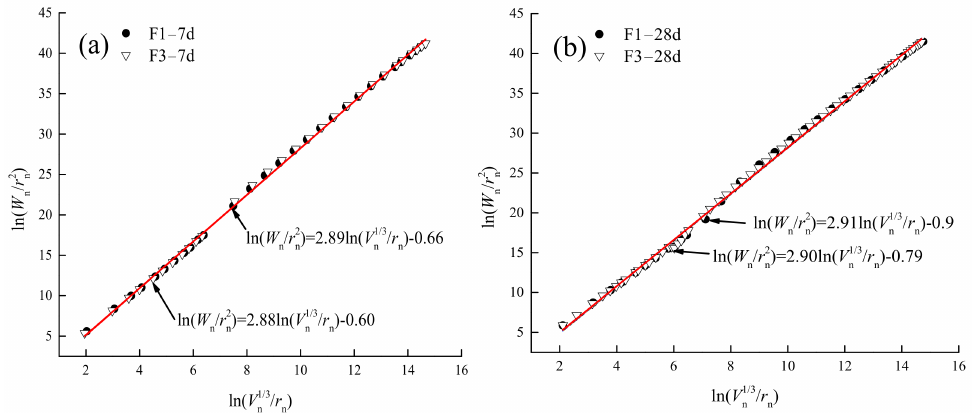
Figure 10. Scatter diagram of slurry pore analysis model for F1 and F3 gelled materials at 7 d and 28 d: ( a ) 7 d, ( b ) 28